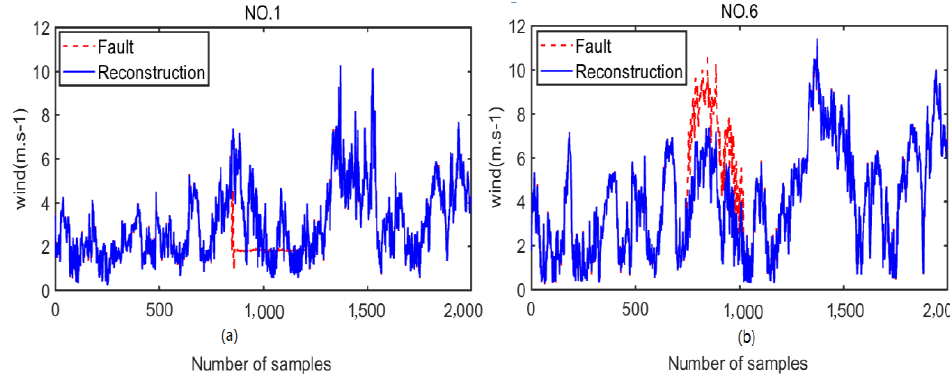
Figure 8. Faulty wind speed and reconstructed wind speed: ( a ) WTG 1; ( b ) WTG 2.